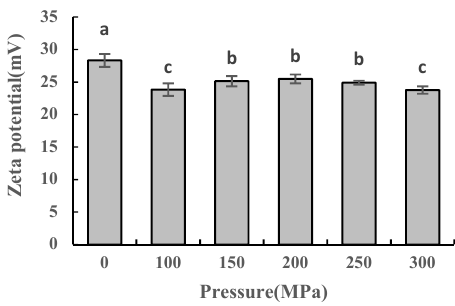
Figure 5. Zeta potential of casein under different pressure conditions. Different superscript letters within a column indicate significant differences between means ( p < 0.05).